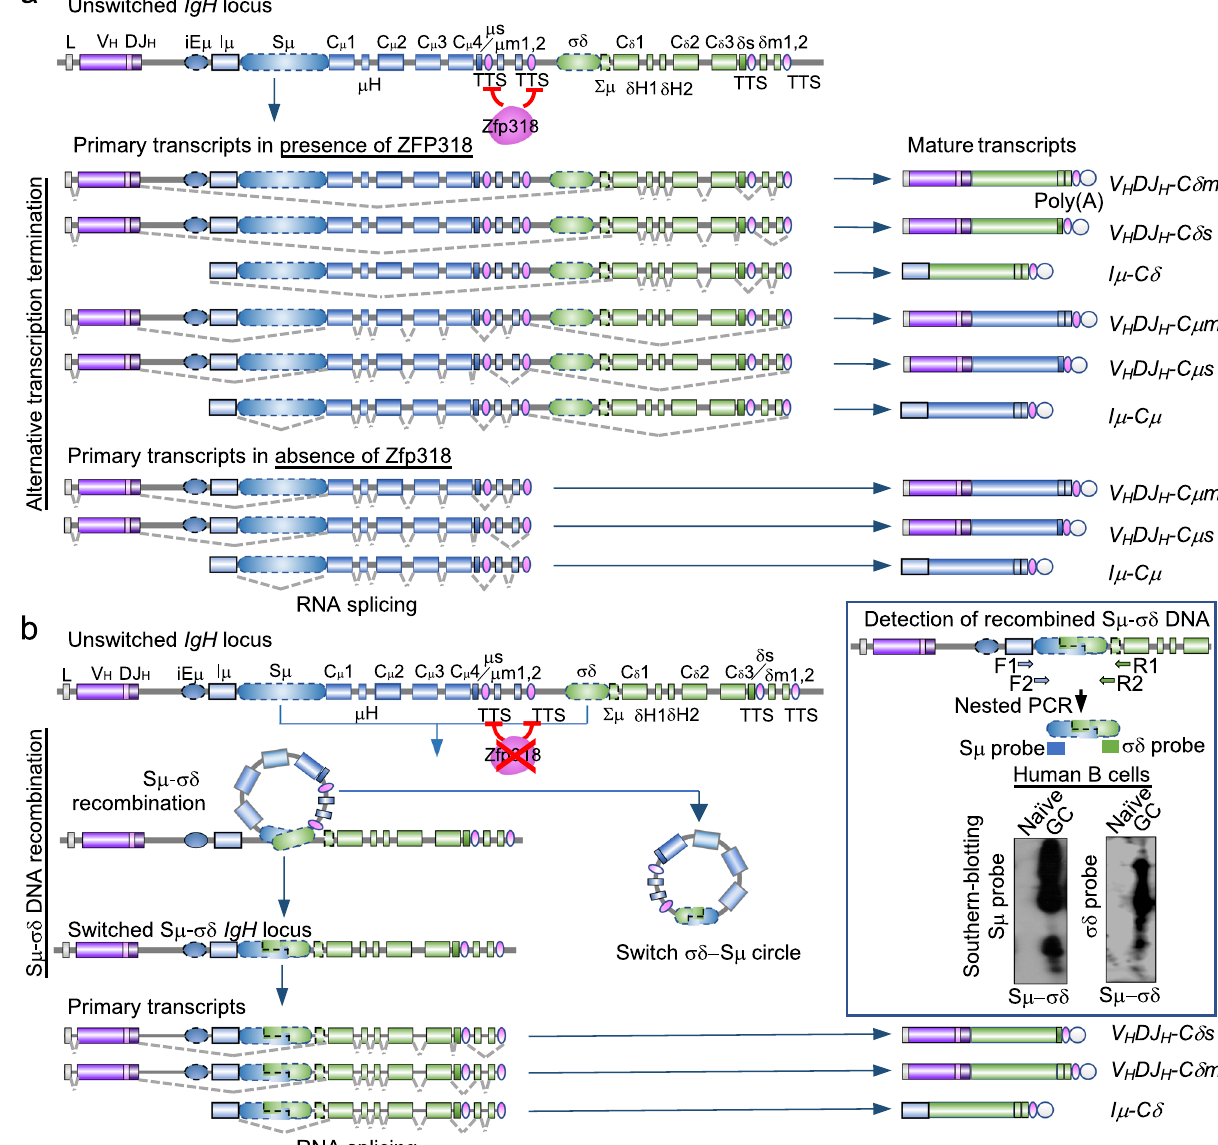
Fig. 1 Expression of cell surface and secreted IgD and IgM, as well as I μ -C δ transcripts by alternative splicing, alternative transcription termination and CSR. a Alternative splicing and alternative transcription termination underpin the expression of germline I μ -C μ and I μ -C δ transcripts, as well as membrane and secreted IgM and IgD in B cells. Expression of IgD stems from either Zfp318-dependent alternative mRNA splicing or S μ – σδ CSR. In the presence of Zfp318, which represses the transcription termination sites (TTS) of the C μ gene, mature B cells constitutively transcribe long primary V H DJ H - C μ -C δ s – m transcripts initiated by the V H promoter. These long primary transcripts undergo alternative splicing which removes intronic regions, leading to dual expression of mature V H DJ H -C μ s and V H DJ H -C δ m transcripts encoding IgM and IgD. In the absence of Zfp318, transcription stops at C μ TTS, resulting in a shorter primary transcript, which does not contain C δ exons, and leads to expression of a mature V H DJ H -C μ − s – m transcript only. Mature B cells also transcribe I μ , C μ , and C δ regions under control of the I μ promoter. When Zfp318 is expressed, unswitched mature B cells constitutively transcribe long primary I μ -C μ − s − m-C δ – s − m transcripts, which undergo alternative splicing to removes intronic regions, leading to dual expression of germline I μ -C μ and I μ -C δ transcripts. In the absence of Zfp318, I μ promoter-initiated transcription stops at C μ TTS, and only germline I μ -C μ transcripts are expressed. b Expression of I μ -C δ transcripts, and membrane and secreted IgD by CSR. Schematic representation of CSR from IgM to IgD. The S μ region recombines with the σδ region and loops out the intervening DNA, which forms a switch circle. The recombined DNA is transcribed leading to expression of V H DJ H -C δ − s – m and I μ -C δ transcripts, initiated by the V H and I μ promoters, respectively — in this case, I μ -C δ transcripts are generated as post-recombination transcripts. Graphics depict portion of the IgH locus and the resulting primary and mature transcripts. Inset depicts the detection of S μ – σδ junctional DNA (CSR to IgD) by nested PCR ampli fi cation followed by Southern-blotting using speci fi c S μ and σδ probes (Southern-blotting of ampli fi ed recombined S μ – σδ DNA from human naïve and germinal center B cells). The ampli fi ed S μ – σδ DNA is sequenced for further analysis of the junctional sequence as well as identi fi cation and census of mutations. iE μ , IgH intronic enhancer; I μ , intervening μ exon; μ m, exon encoding the transmembrane region of IgM; δ m, exon encoding the secretory piece of IgM; σδ , noncanonical switch-like region 5 ′ to C δ ; δ s, exon encoding the secretory region of IgD; C δ m, exon encoding the transmembrane region of IgD. Dotted gray lines show splicing of primary transcripts to yield secreted and transmembrane forms of IgM and IgD.